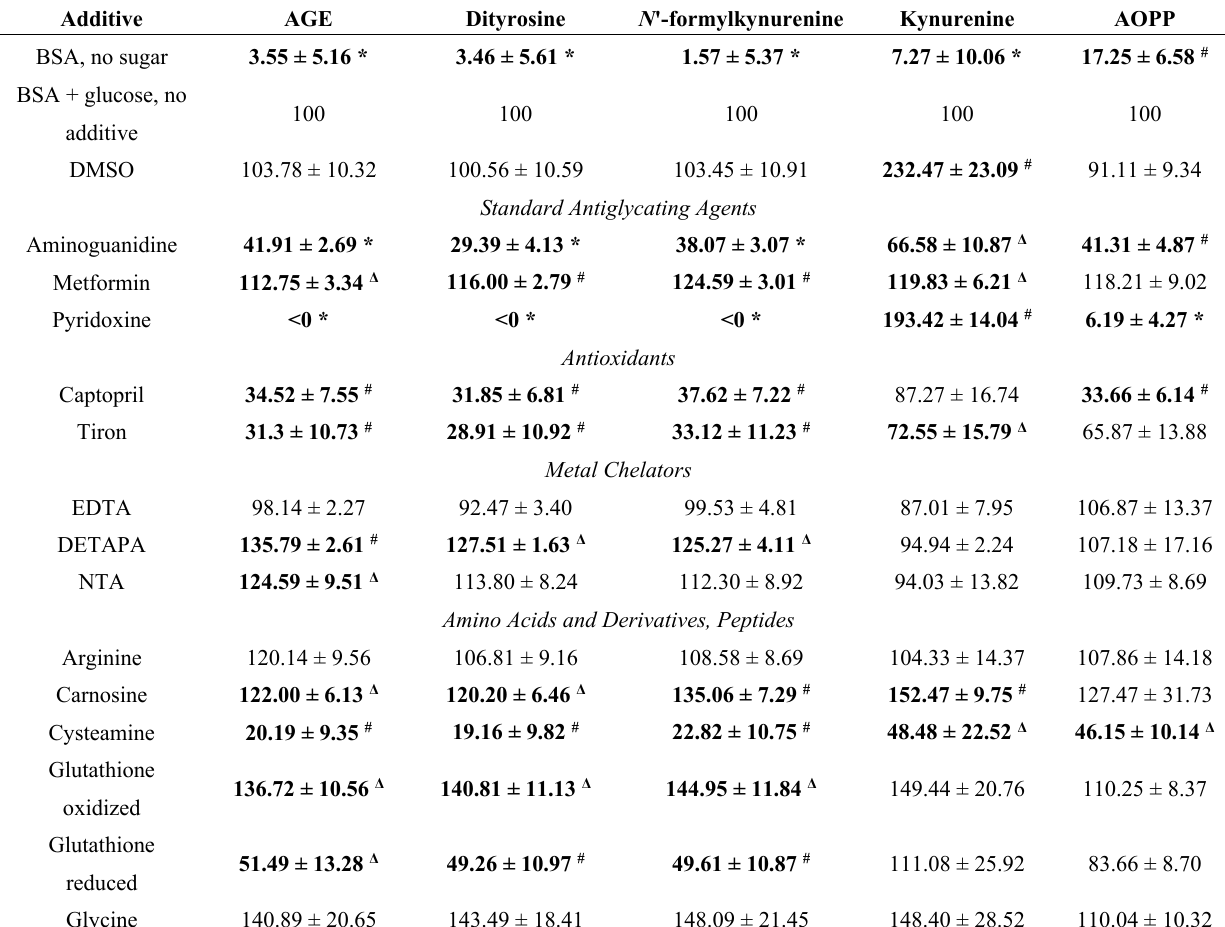
Table 1. The effect of various additives (1 mM) on the extent of the glycoxidation of BSA induced by glucose (0.5 M), estimated with fluorometric parameters. Δ p < 0.05, # p < 0.01, * p < 0.001 (paired Student’s t -test). Results significantly different from samples incubated with the sugar without additives are shown in bold. DETAPA, diethylenetriaminepentaacetic acid; NTA, nitrilotriacetic